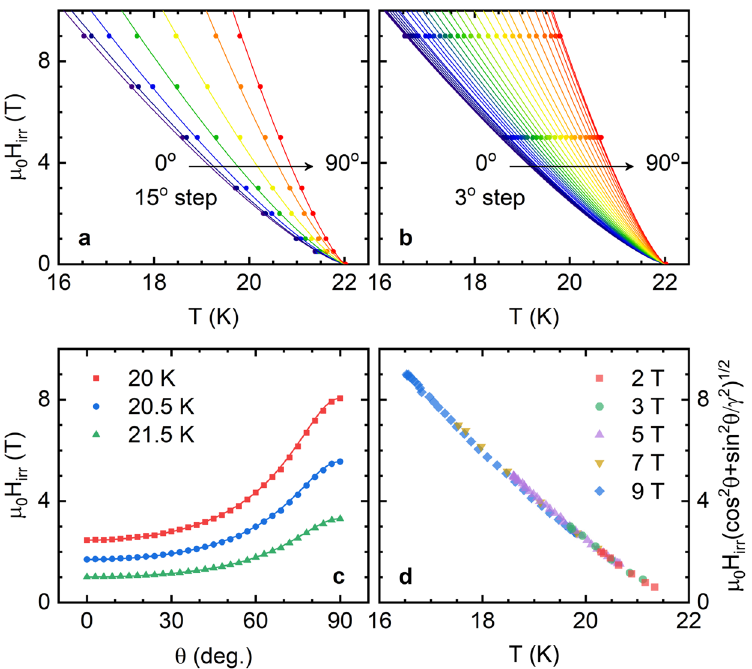
Figure 6. ( a ) Temperature dependence of the irreversibility field for different field orientations, obtained from a 1% of ρ B ( T c ) criterion. The lines are a fit of a power law H irr = A (θ)( T − T c ) leads to n ≈ 1.3 . ( b ) H irr ( T ) θ in steps of 3 ◦ , obtained from the detailed 5 T and 9 T data in Fig. 1f, h. The lines are fits to the above power law with n fixed to 1.3, that allowed us to obtain the H irr (θ) presented in ( c ). In this case the 3D-aGL approach (solid line) accounts for the angular dependence of H irr in the entire θ range. ( d ) 3D-aGL scaling of the irreversibility field, obtained with γ = 3.27